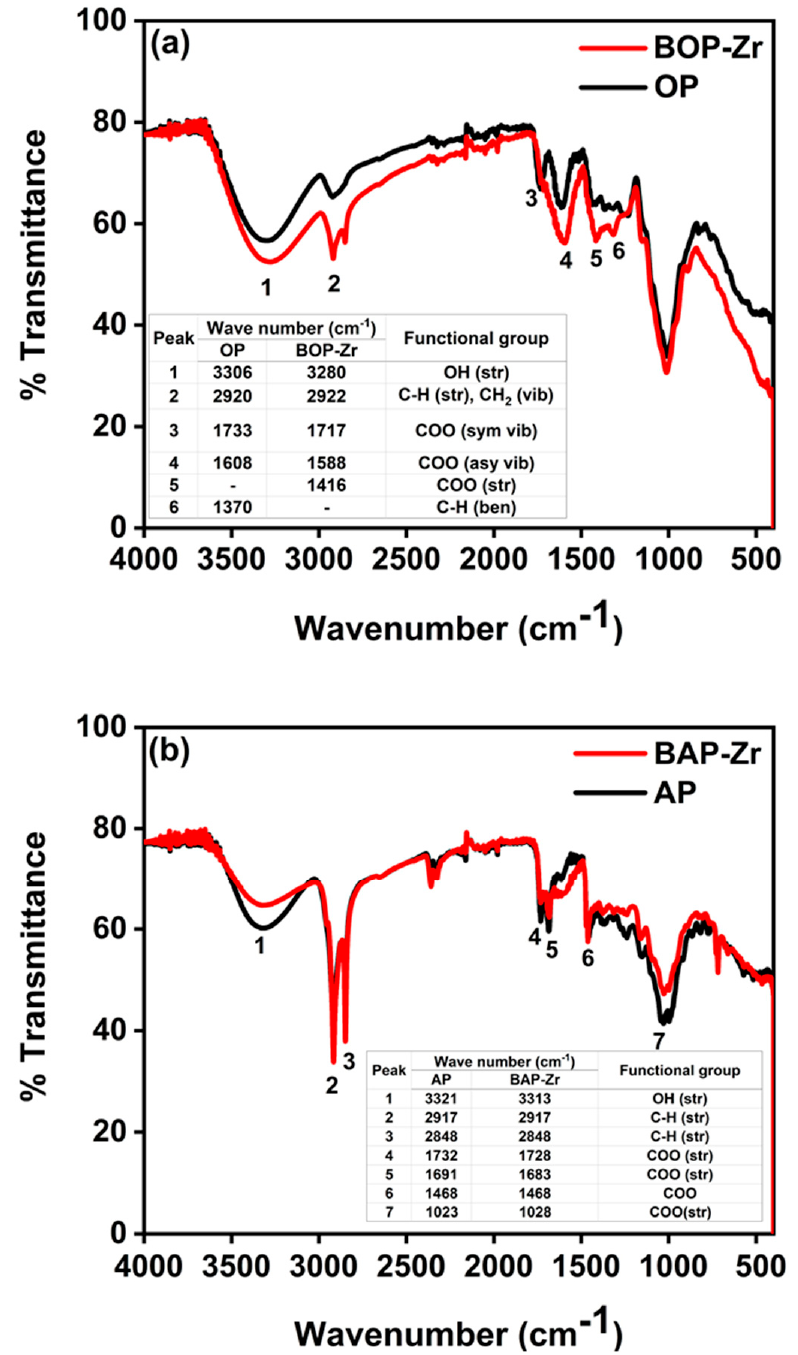
Figure 3. FTIR-ATR spectra of ( a ) OP and BOP-Zr, ( b ) AP and BAP-Zr.